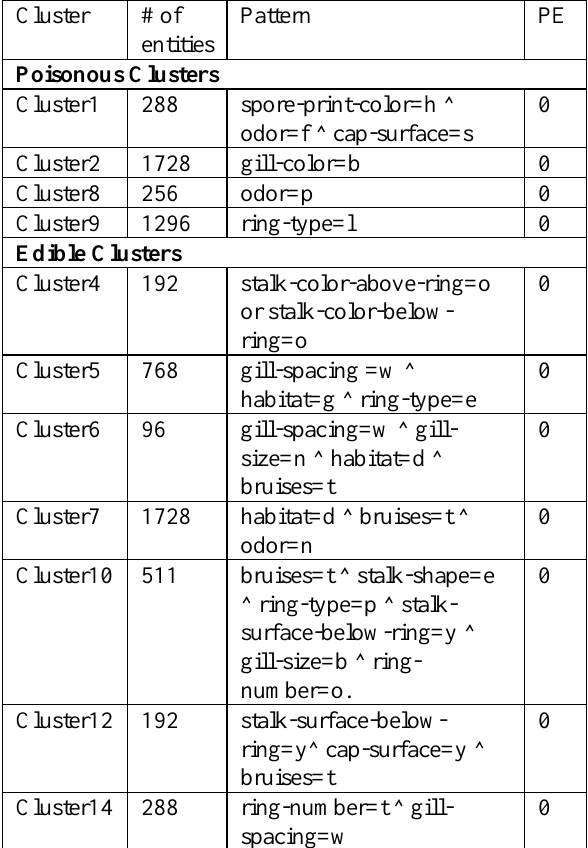
Table 5: Mushroom clusters